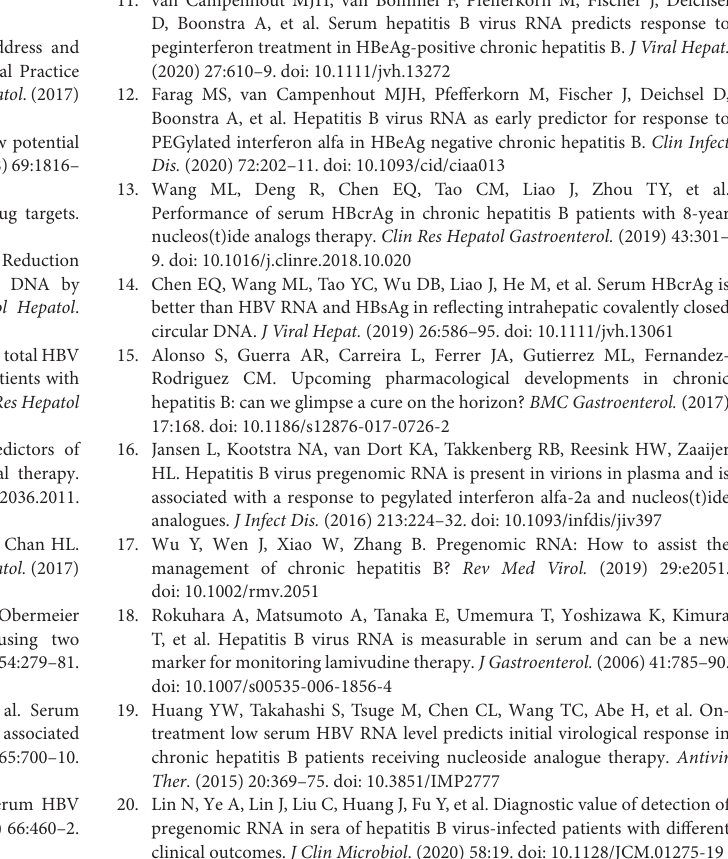
Supplementary Figure 1 | Dynamic changes of serum pgRNA in HBeAg-positive (A) and -negative (B) patients. Comparison of the baseline serum pgRNA levels in patients of different age (C) and different sex (D) . P -values between the groups were calculated using chi-squared test. Supplementary Figure 2 | Among patients with negative HBV DNA (A) , and with negative HBV DNA and pgRNA (B) at month 96, baseline serum pgRNA levels were compared between the groups of HBsAg < 500 IU/mL and > 500 IU/mL. P -values between the groups were calculated using chi-squared